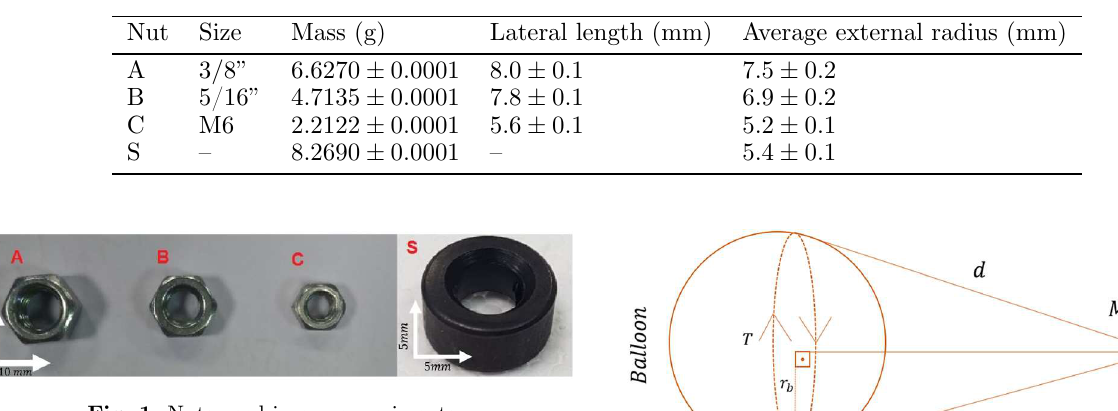
Table 1. Characteristics of the nuts.